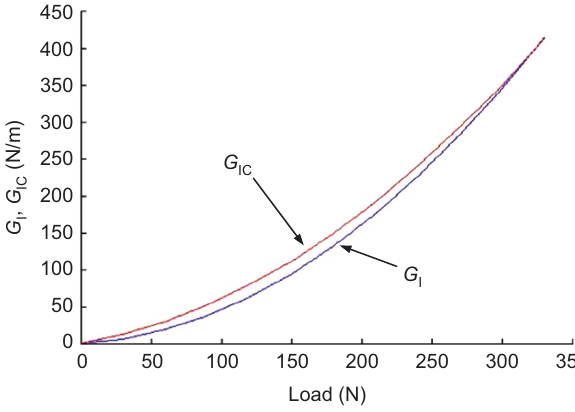
Figure 5 Energy release rate load diagram obtained from the meshfree method for the [0/45/-45/90/0]